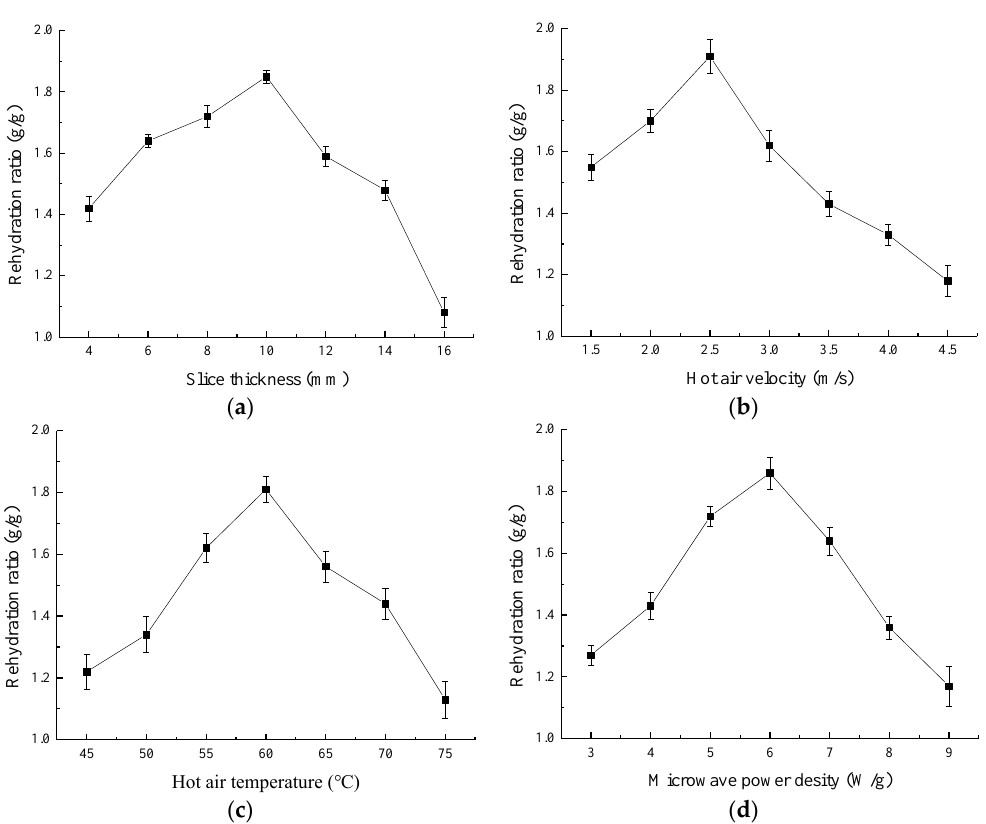
Figure 2. The effects of independent variables on rehydration ratio (RR). ( a ) Effect of slice thickness of yam slices on RR; ( b ) Effect of hot air velocity on RR; ( c ) Effect of hot air temperature on RR; ( d ) Effect of microwave power density on RR.